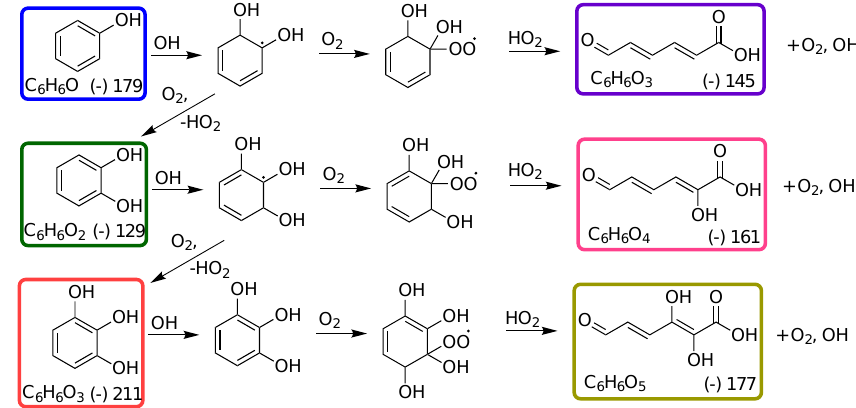
Fig. 3. Proposed pathway for gas-phase production of C 6 carboxylic acids in the phenol low-NO x system. Boxed structures indicate that the expected m/z from the chemical ionization reactions in the CIMS for that compound was detected.